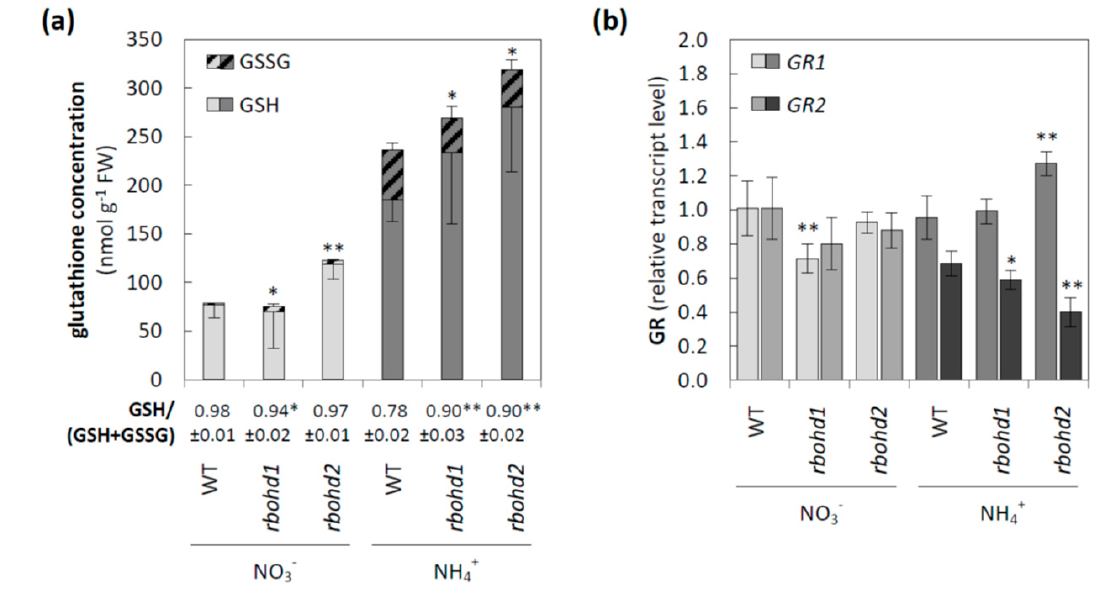
Figure 4. Glutathione-related leaf antioxidant system in WT and rbohd plants cultivated in the presence of nitrate or ammonium as a sole nitrogen source. ( a ) Reduced glutathione and glutathione disulfide concentration. ( b ) The transcript level of glutathione reductase 1 and glutathione reductase 2. Comparison tests between rbohd and WT plants were performed on the mean of experimental conditions for the nitrate (light grey) or ammonium (dark grey) growth regime separately. Statistical differences calculated using one-way analysis of variance (ANOVA) with Tukey’s post hoc test are indicated at p -value ≤ 0.01 ** and p -value ≤ 0.05